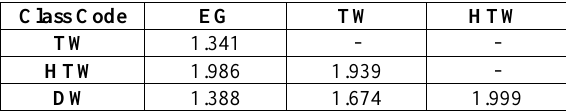
J-M distances computed with the class training areas for the Landsat-8 OLI bands for the September image mosaic.